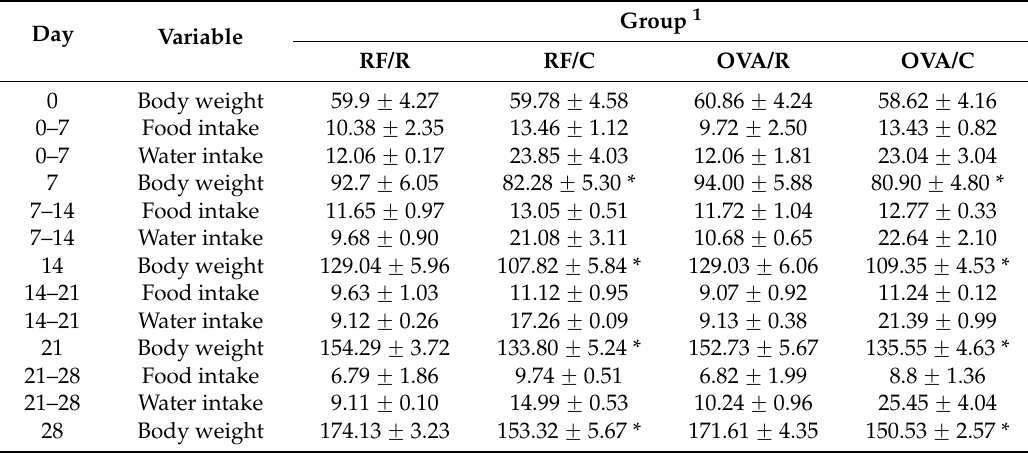
Table 3. Body weight (g) and food and water intake (g/100 g rat/day) from the four groups over the study. Data represent mean ˘ standard error ( n = 9 for body weight, n = 3 for water and food intake established in each cage). Statistical difference: * means statistical significant difference induced by the diet by two-way ANOVA ( p <